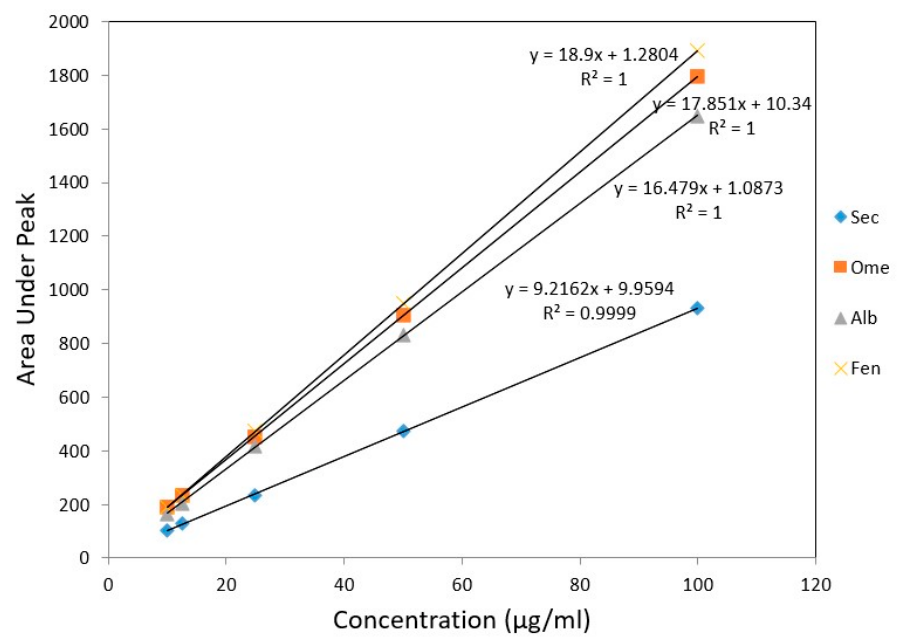
Figure 6. Calibration curves for authentic mixture of SEC, OME, ALB, and FEN using the proposed HPLC method.